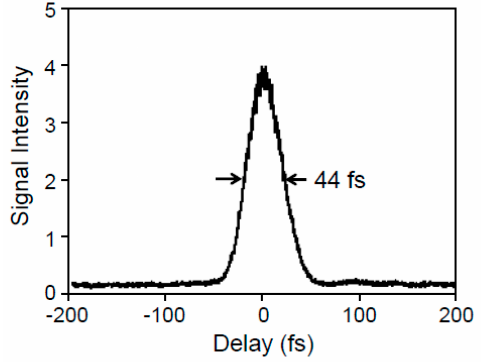
Figure 4. Intensity autocorrelation trace observed for the Ti:sapphire